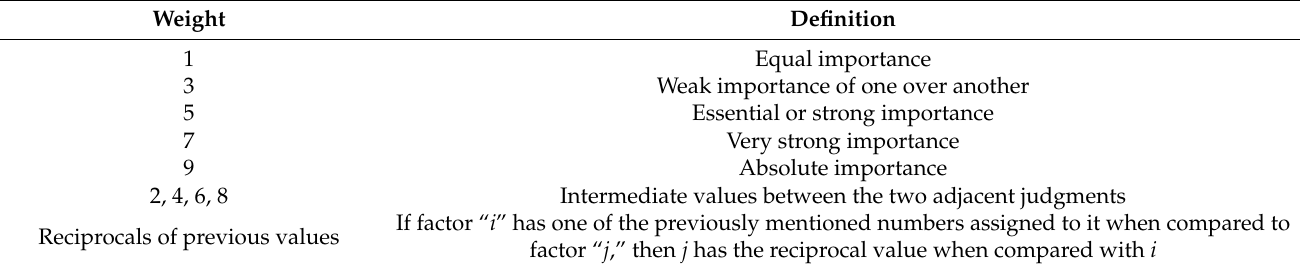
Table 1. The comparison scale of the Analytical Hierarchy Process (AHP)